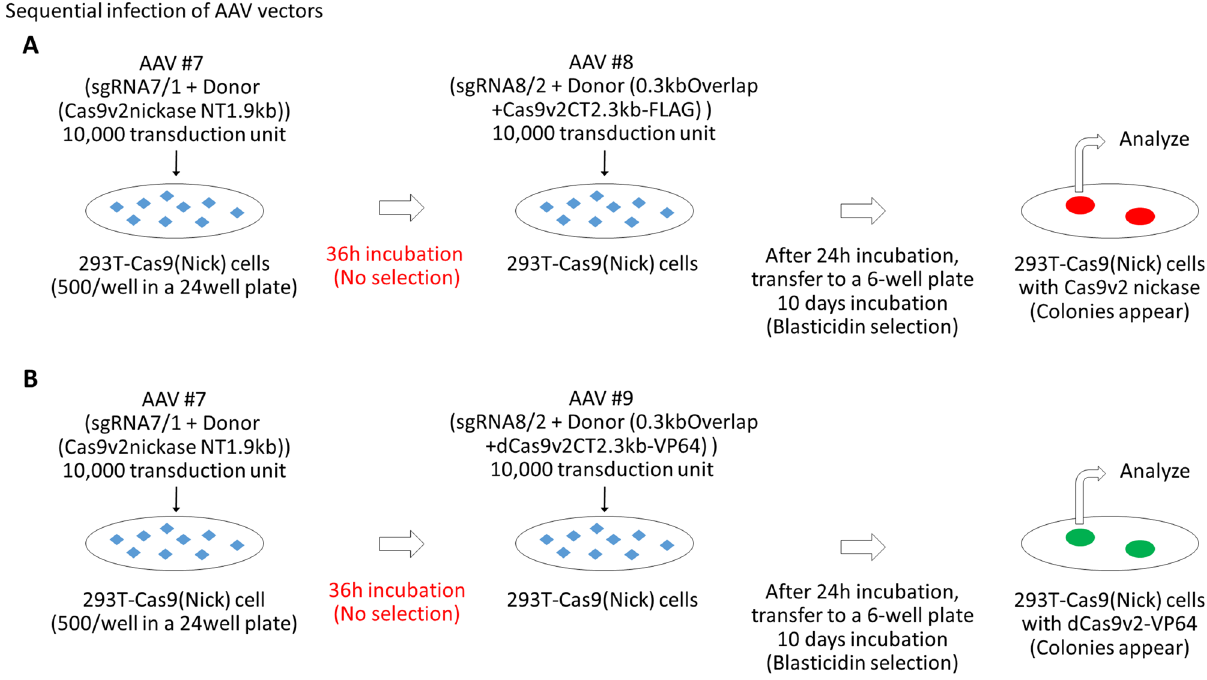
Figure 8. Sequential transduction procedure using AAV vectors. ( A ) According to the scheme shown in figure, 293 T-Cas9(Nick)-Myc cells (500/well) plated in a 24-well plate were incubated with 10,000 transduction units of AAV#7, which provided sgRNA targeting the AAVS1 site, and 1.9 kb Cas9v2 nickase N-terminal fragments (Supplementary Fig S11), for 36 h. Following medium aspiration, cells were sequentially incubated with 10,000 transduction units of AAV#8 (Supplementary Fig S12), for 24 h, to reconstitute full-length Cas9 (v2) nickase- FLAG. Cells were transferred to a 6-well plate, with blasticidin added two days after transfer. Colonies